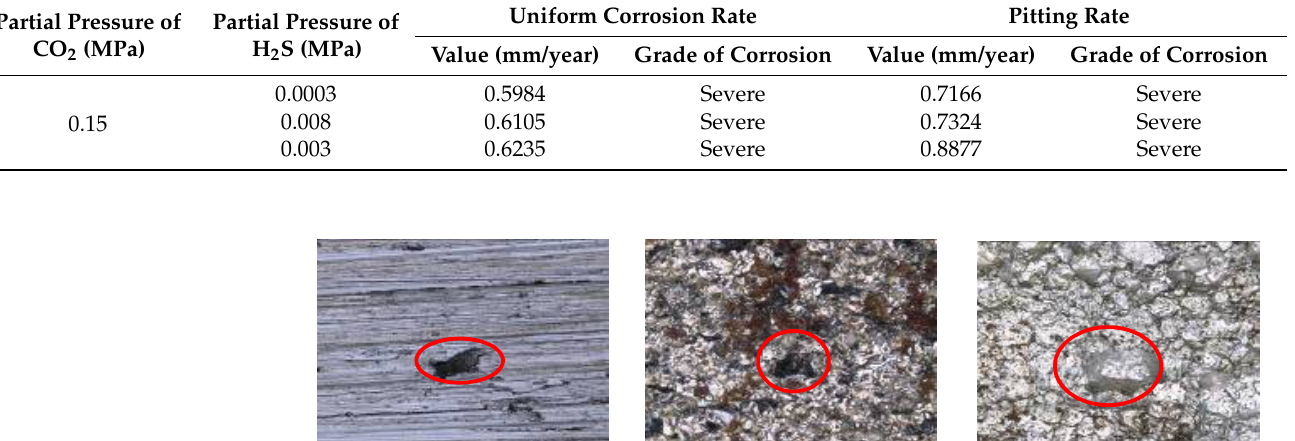
= 0.15 MPa; = 0.15 MPa; 2 2